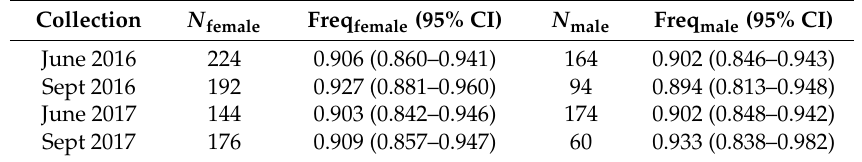
Table 1. Frequency of the MtnA 3’ UTR deletion across seasons and sexes.